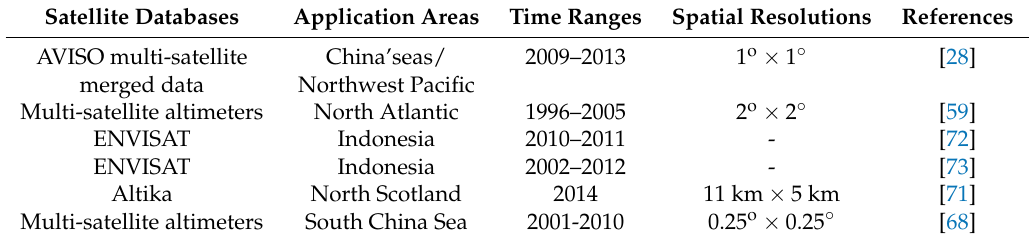
Table 4. Non-exhaustive review of satellite altimeters databases exploited for wave energy resource